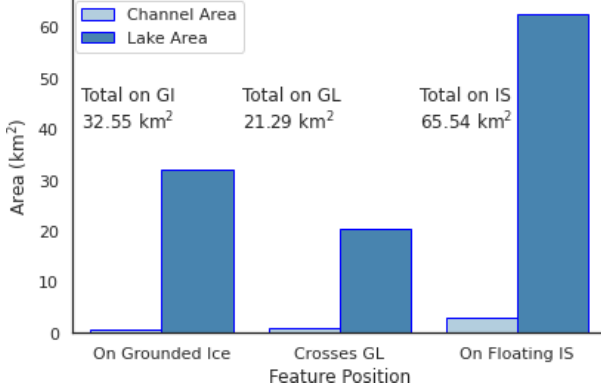
Figure 8. Area split between channels and lakes completely on grounded ice (GI), crossing the grounding line (GL) and completely on floating ice shelves (IS) across the WAIS and